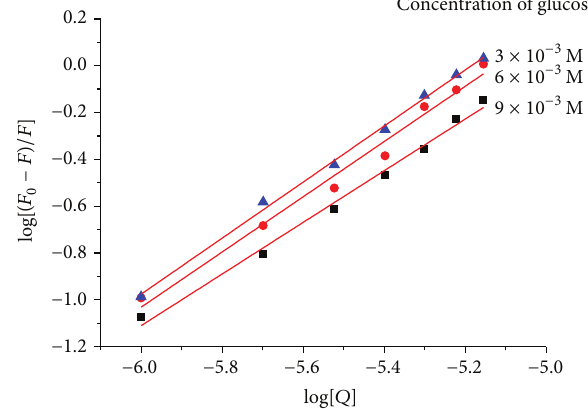
Figure 8: Synchronous fluorescence spectra of interaction between HSA and Hyp; from curve 1 to 8, 𝐶 ( 2, 3, 4, 5, 6, and 7 × 10 −6 M, respectively.